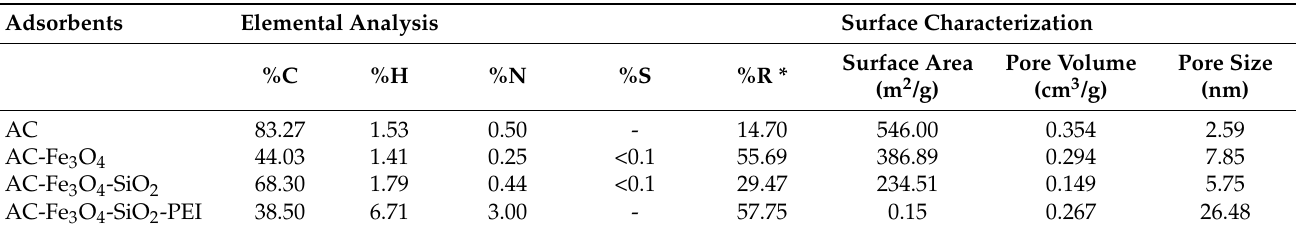
Table 1. Elemental analysis and surface characterization of adsorbents.